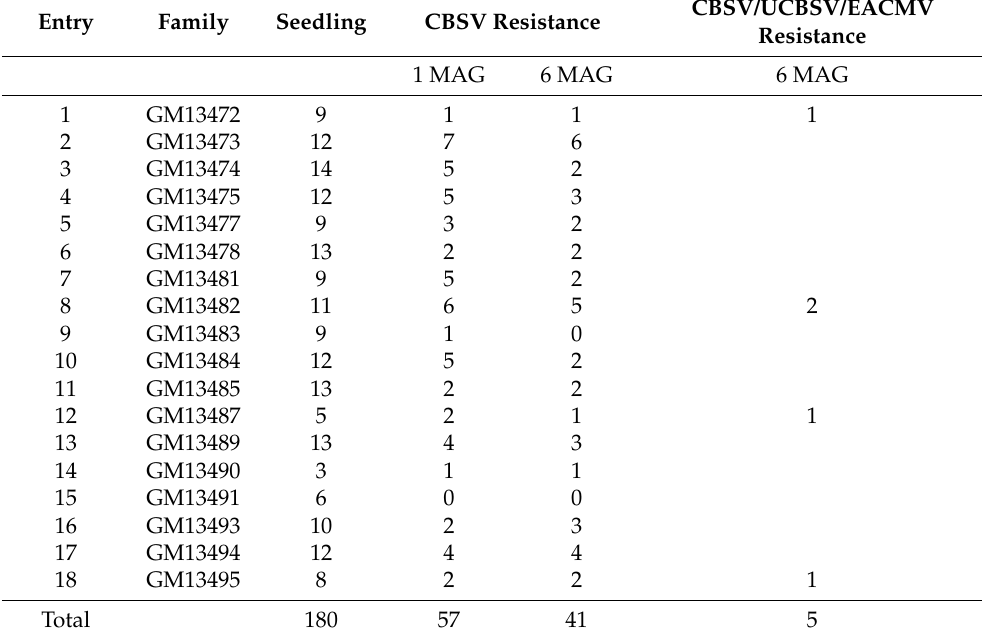
Table 3. Virus resistance screening of 18 cassava seedling populations generated from crosses between U/CBSV- and EACMV-resistant parents. Evaluation of resistance against UCBSV and EACMV was only performed with the 41 cassava lines that had CBSV resistance. CBSV/UCBSV/EACMV Entry Family Seedling CBSV Resistance Resistance 1 MAG 6 MAG 6